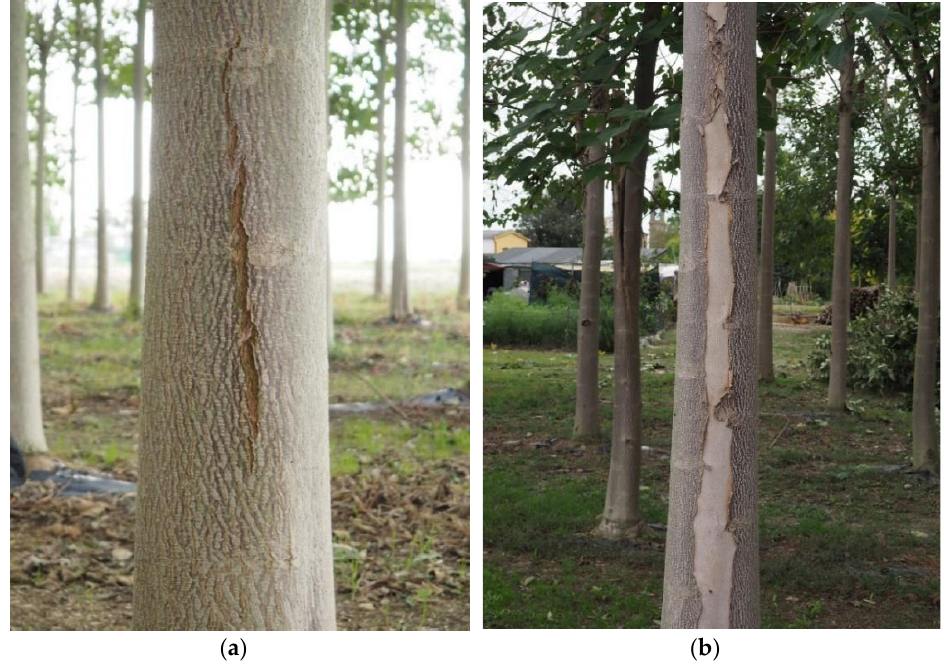
Figure 7. Wind shakes ( a ) and sun scald of the rhytidome ( b ) observed at plantation C.